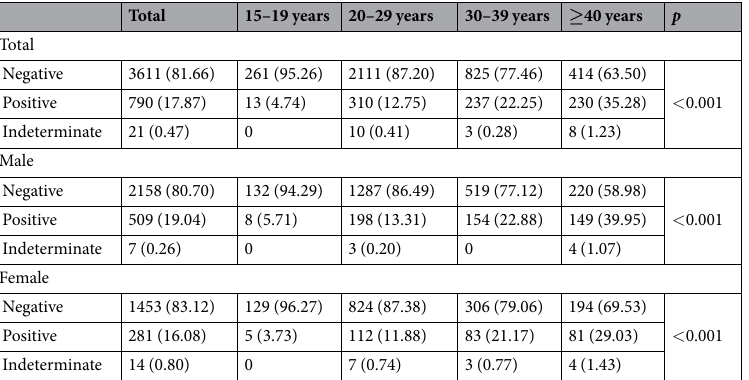
Table 2. Results of QuantiFERON-TB Gold In-Tube (QFT) among study populations by age and